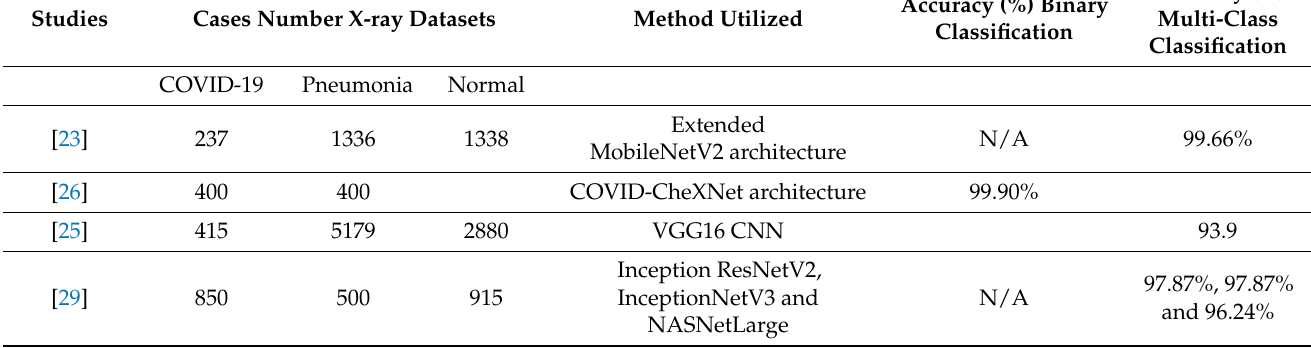
Table 3. State-of-the-art comparison COVID-19